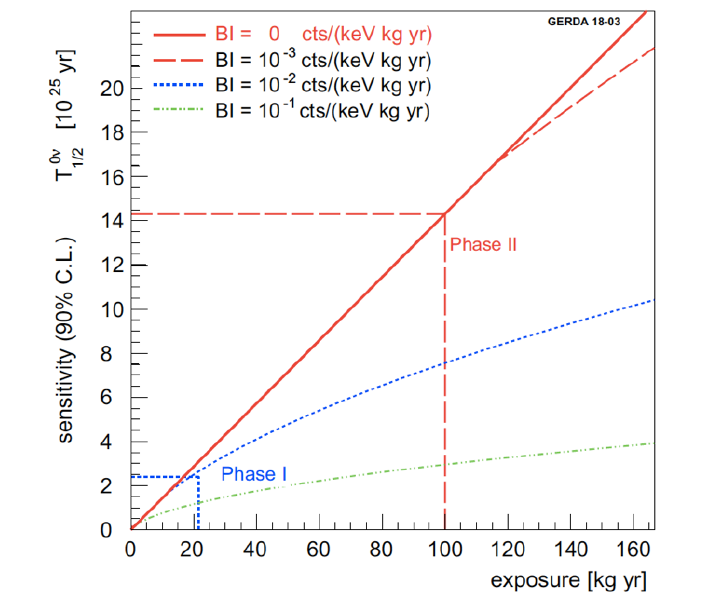
Figure 1. The G ERDA sensitivity on the 0 νββ half-life ( T 0 ν for different